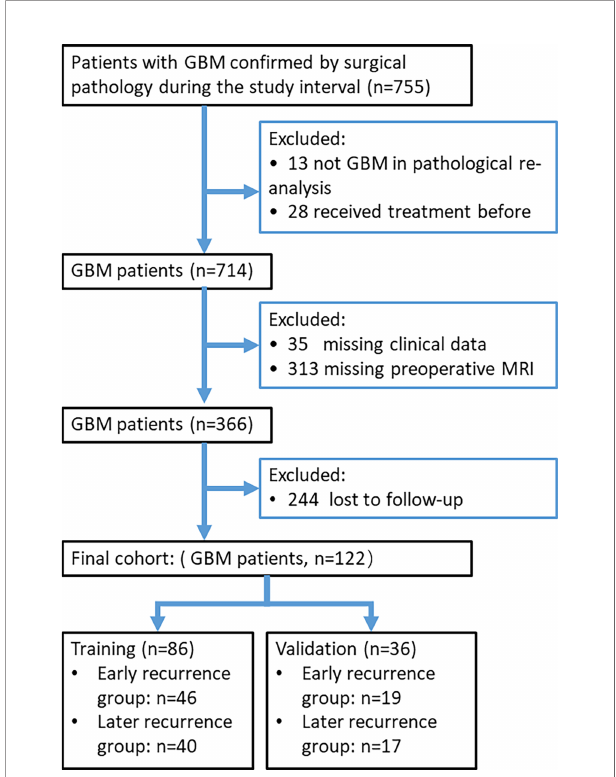
FIGURE 1 | Study recruitment process for patients with glioblastoma multiforme